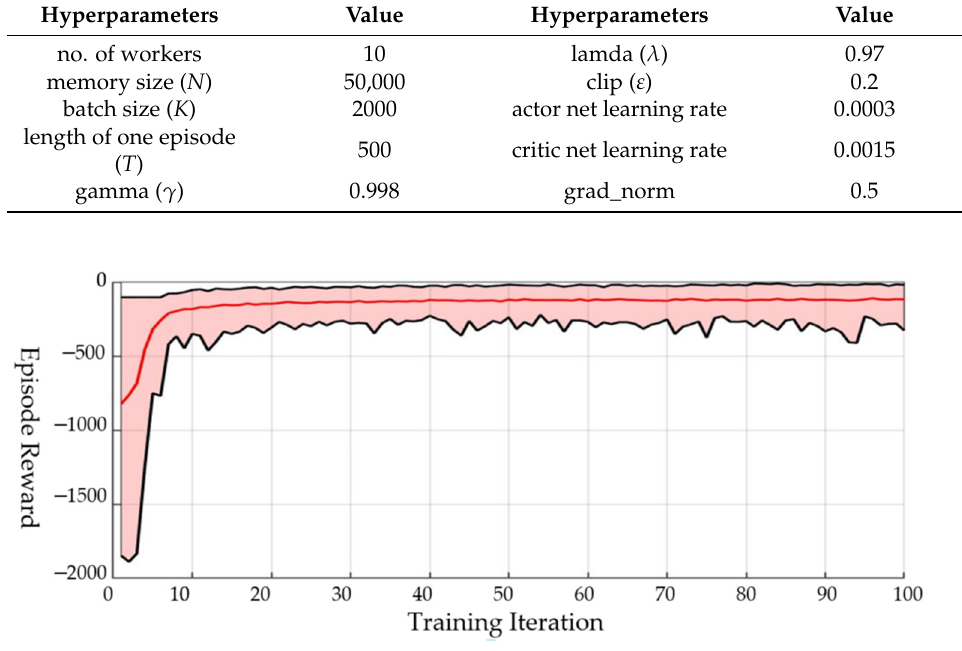
Figure 7. Training result of the guidance control neural network. Table 1. List of hyperparameters for Batch-PPO algorithm.